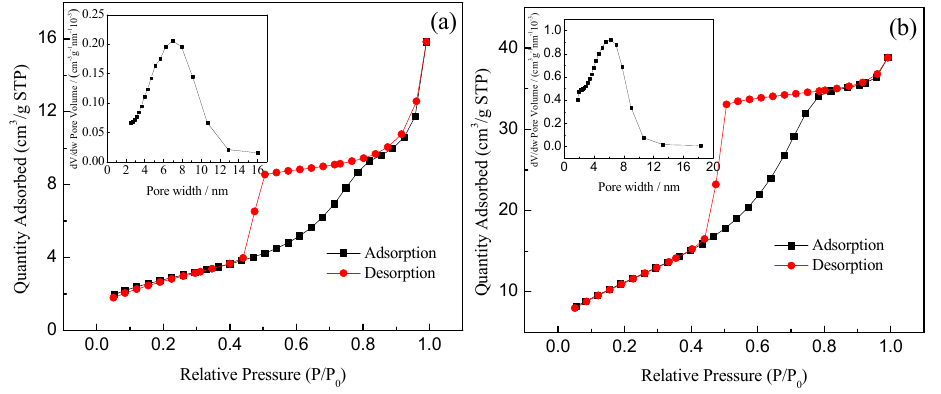
Figure 4. N 2 adsorption-desorption isotherms and pore size distributions (inset) of pure TiO 2 ( a ) and 0.75% La/TiO 2 ( b ).